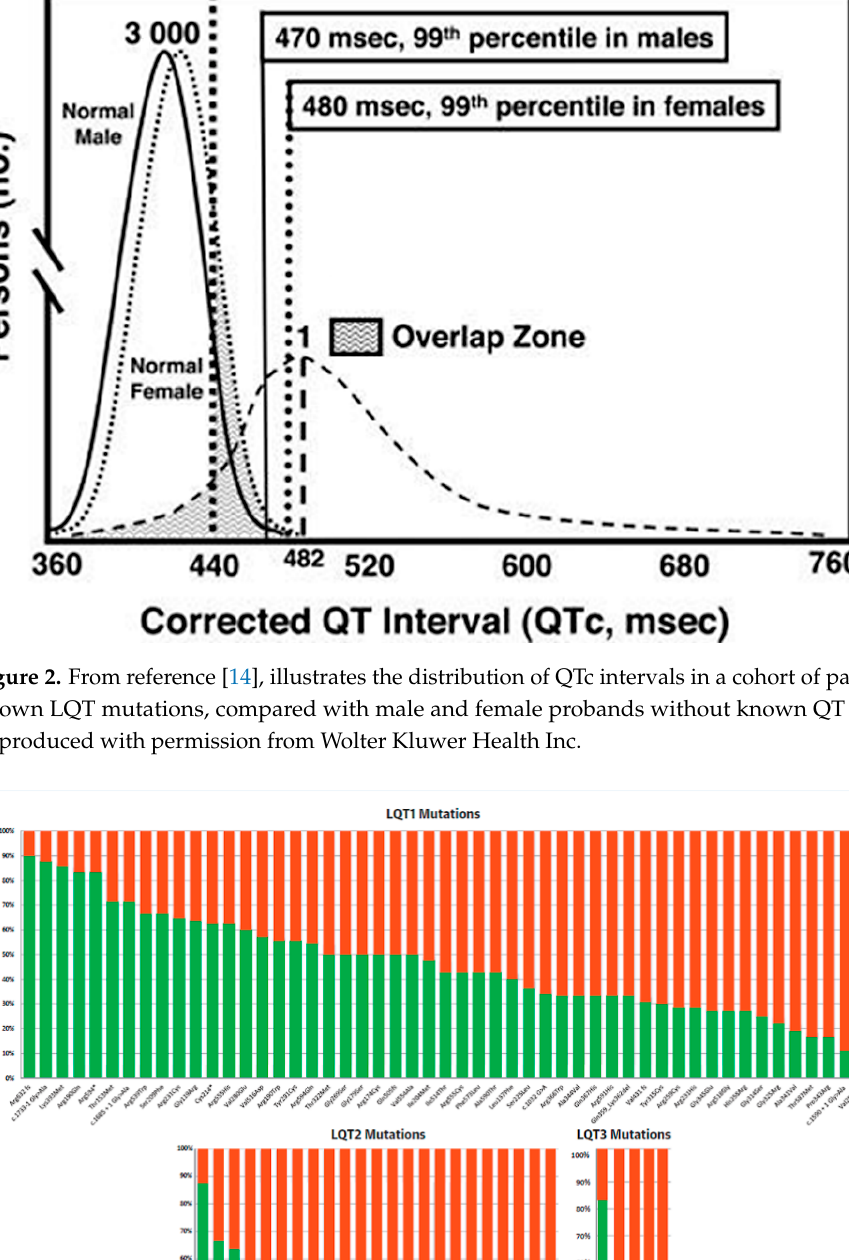
Figure 3. From reference [15] illustrates the distribution between concealed (green fraction) and overt (red fraction) in 53 mutations with LQT1, 23 mutations with LQT2 and 5 mutations in LQT3. Reproduced with permission from Elsevier Publisher.